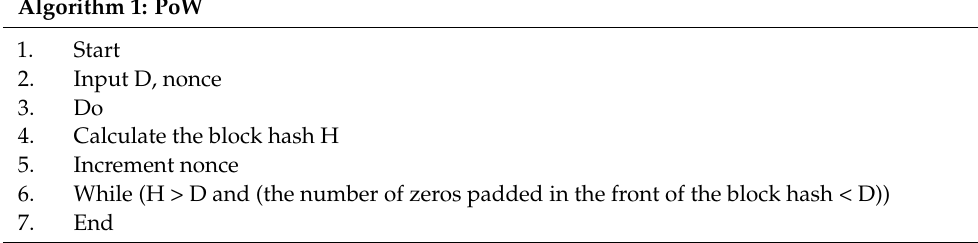
Table 1. Simulation Set up .